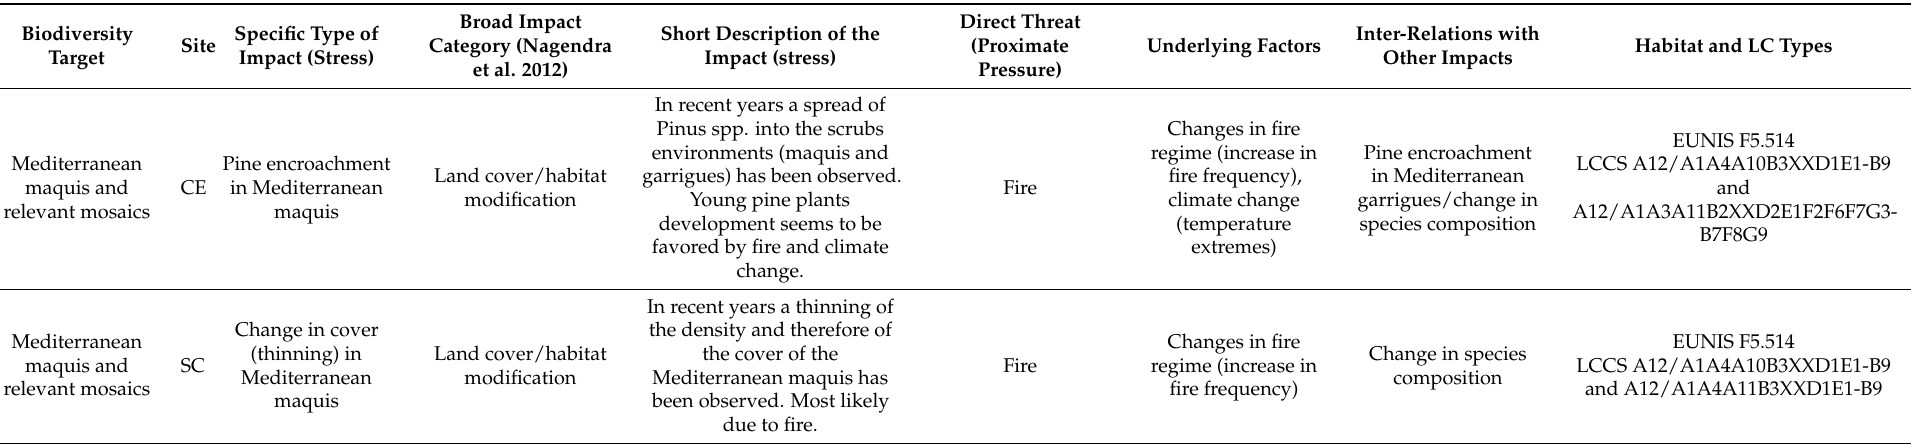
Table A2. List of the impacts affecting natural and seminatural habitat types in the study sites. For each specific type of impact the following are included: biodiversity target, a short description of the impact, broad categories of observed impacts, proximate pressures, underlying factors, inter-relations with other impacts and the habitat/LC type corresponding to the biodiversity target (according to EUNIS and LCCS taxonomies). In some cases, impacts on abiotic systems can become direct threats to biotic systems (e.g., changes in the water regime of coastal lagoons that lead to the loss of annual glasswort communities (EUNIS A2.55) or changes in water quality (water salinization) in coastal lagoons that become direct threats to reed beds (loss of reed beds